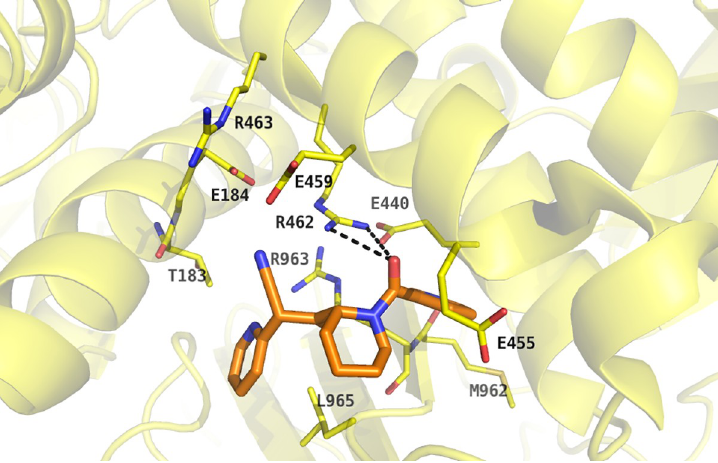
Fig 9. Predicted binding mode for compound 18. The GMII protein (PDB code: 1HWW [3]) is shown as transparent , yellow-coloured cartoon with binding site residues being displayed as stick representation with yellow- coloured carbon atoms. Compound 18 is represented with orange coloured carbon atoms and black dashes indicate potential hydrogen bonds between the virtual screening hit and the target